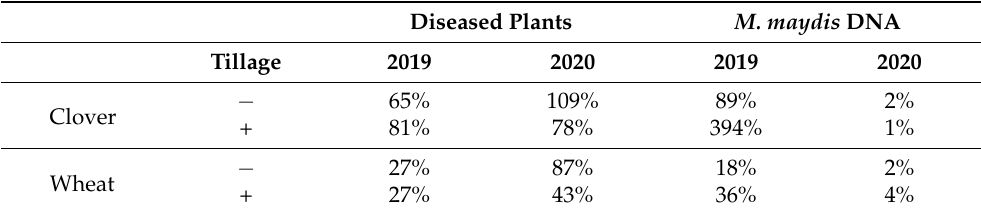
Table 8. Comparative analysis of the 2019 and the 2020 experiments plants’ health results at the harvest day 1